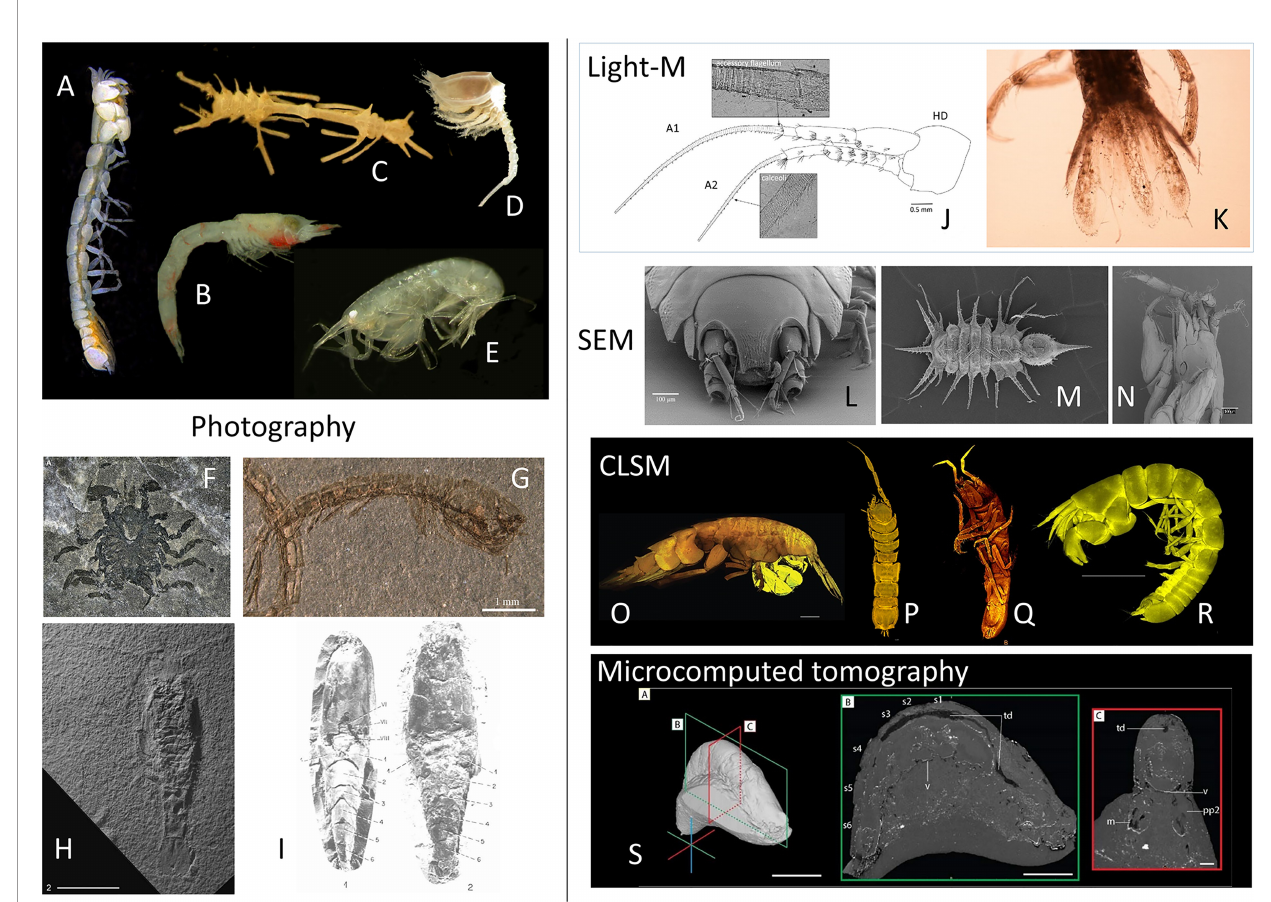
FIGURE 3 | Peracarida specimens visualized applying different modern imaging techniques to complement the taxonomical description of species. (A – G) Digital still camera on stereomicroscope. (H, I) Still camera. (J, K) dissected specimen under Light microscope. (L – N) Scanning Electron Microscope. (O – R) Confocal Laser Scanning Microscope. (S) Microcomputed tomograph. (A) The paranarthrurellid tanaidacean Armatognathia swing B ł az ̇ ewicz and Jo ́ z ́ wiak, 2019 from B ł az ̇ ewicz et al. (2019) under Creative Commons license. (B) The mysid Paramblyops rostratus (Holt and Tattersall, 1905) from Frutos (2017). (C) The ischnomesid isopod Cornuamesus longiramus (Kavanagh and Sorbe, 2006), and (D) the diastylid cumacean Campylaspis vitrea Calman, 1906 from Frutos et al. (2017a). (E) The leucothoid amphipod Leucothoe cathalaa Frutos and Sorbe, 2013 from Frutos and Sorbe (2013). (F) The fi rst asellote isopod from the fossil record Fornicaris calligarisi Wilson and Selden, 2016 from Selden et al. (2016), © The Crustacean Society, reprinted with permission of Oxford University Press on benhalf of The Crustacean Society. (G) The oldest crown cumacean Eobodotria muisca Luque and Gerken, 2019 from Luque and Gerken (2019), reprinted with permission of Royal Society Publishing. (H) The oldest known fossil mysid Aviamysis pinetellensis San Vicente and Cartanyà, 2017 from San Vicente and Cartanyà (2017), reprinted with permission of Cambridge University Press. (I) Two fossil lophogastrids of family Lophogastridae from Secre ́ tan and Riou (1986), reprinted with permission of Annales of Pale ́ ontologie. (J) The eusirid amphipod Dorotea papuana Corbari, Frutos and Sorbe, 2019 from Corbari et al. (2019). (K) The paranthurid isopod Paranthura santiparrai Frutos, Sorbe and Junoy, 2011 from Frutos et al. (2011). (L) The nannoniscid isopod Austroniscus obscurus Kaiser and Brandt, 2007 from Kaiser and Brandt (2007). (M) The paramunnid isopod Pentaceration bif fi clyro Kaiser and Marner, 2012 from Kaiser and Marner (2012). (N) The paranthurid isopod Paranthura santiparrai Frutos, Sorbe and Junoy, 2011 from Frutos et al. (2010). (O) The oedicerotid amphipod Oedicerina teresae Jaz ̇ dz ̇ ewska, 2021 from Jaz ̇ dz ̇ ewska et al. (2022) under Creative Commons license. (P) The nannoniscid isopod Thaumastosoma platycarpus Hessler, 1970 from Kaiser et al. (2018). (Q) The nannoniscid isopod Nannoniscus magdae Kaiser, Brix and Jennings, 2021 from Kaiser et al. (2021). (R) The paranthrurellid tanaidacean Paranarthrurella arctophylax (Norman and Stebbing, 1886), from B ł az ̇ ewicz et al. (2019) under Creative Commons license. (S) Fossil lophogastrid specimen showing internal anatomy after microcomputed tomography, from Jauvion